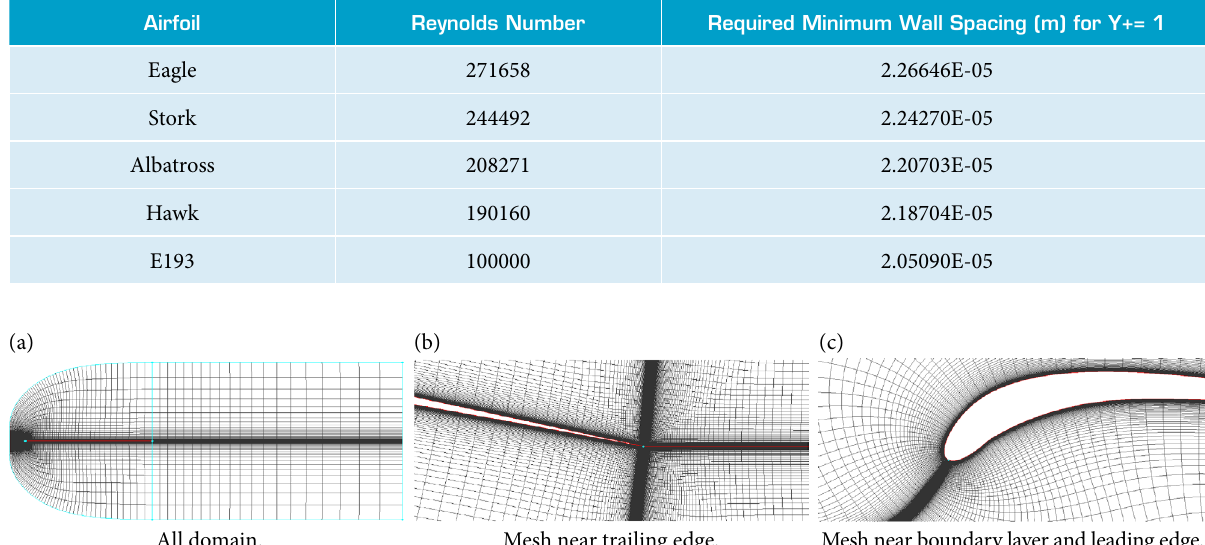
Table 1. Reynolds number and required minimum wall spacing for the airfoils.